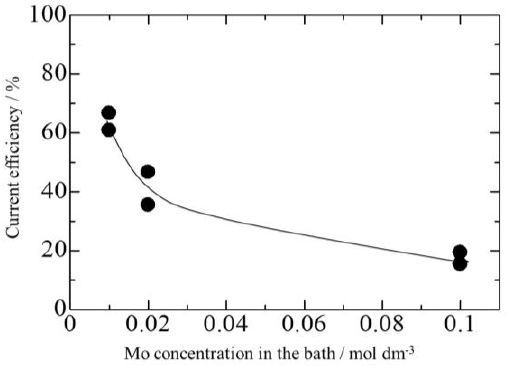
Figure 15. The relationship between Mo concentration and current efficiency.